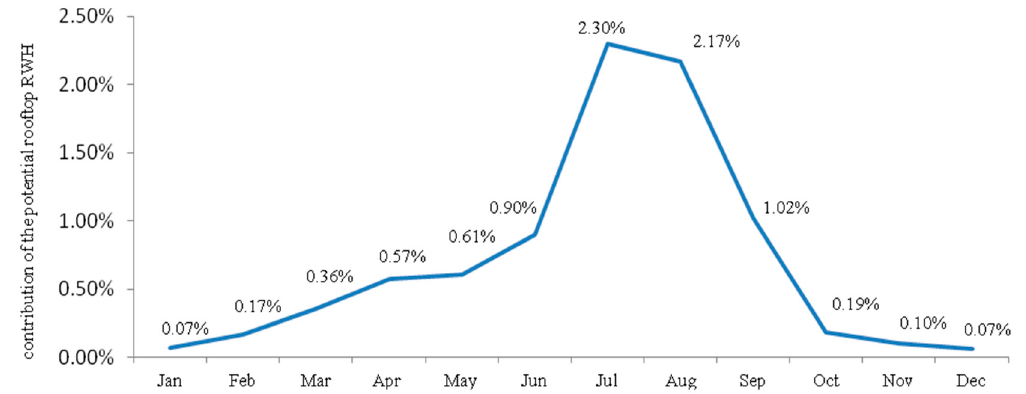
Figure 3. Contribution of rooftop RWH from large public institutions to supplement water supply at the city level.